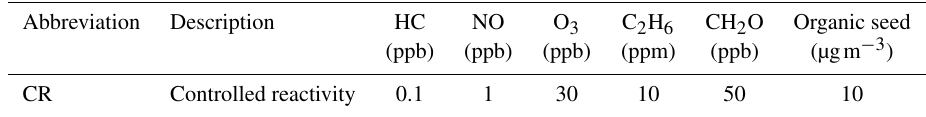
Table 2. Initial conditions for camphene, α -pinene, and limonene controlled reactivity simulations. The levels of O 3 and NO x were fixed during these simulations. Abbreviation Description Controlled